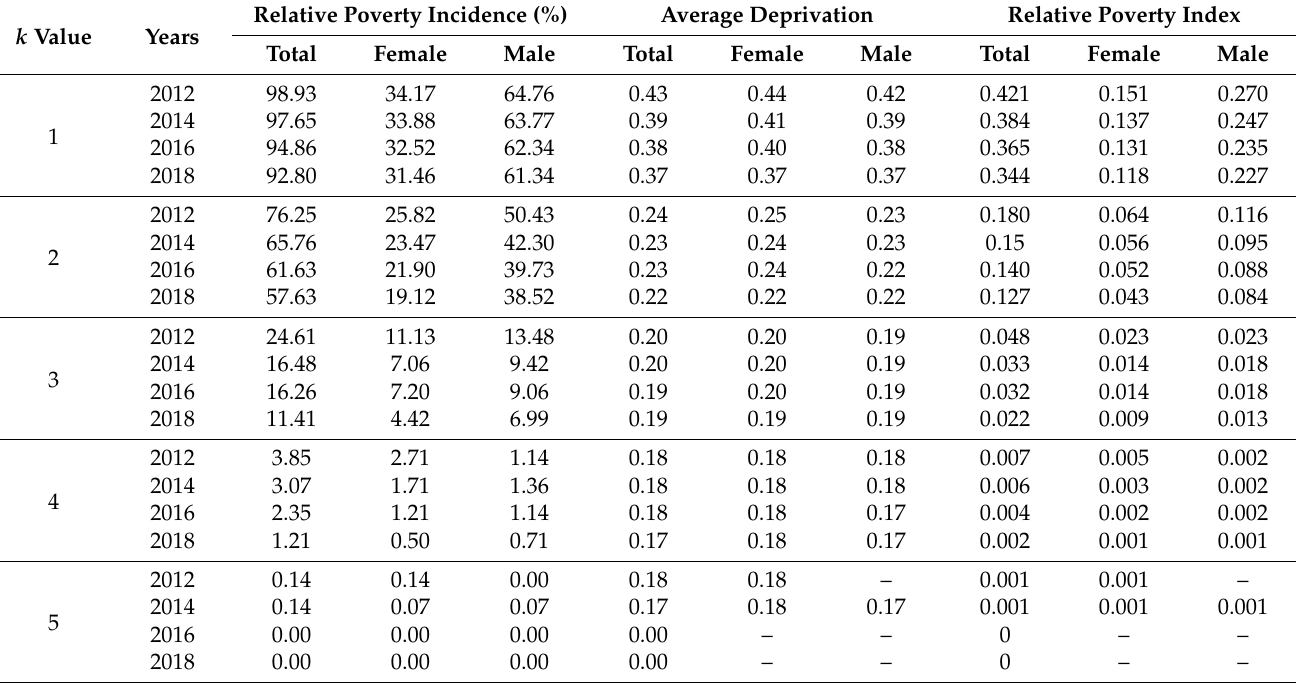
Table 2. Results of migrant workers’ relative poverty measurement and gender